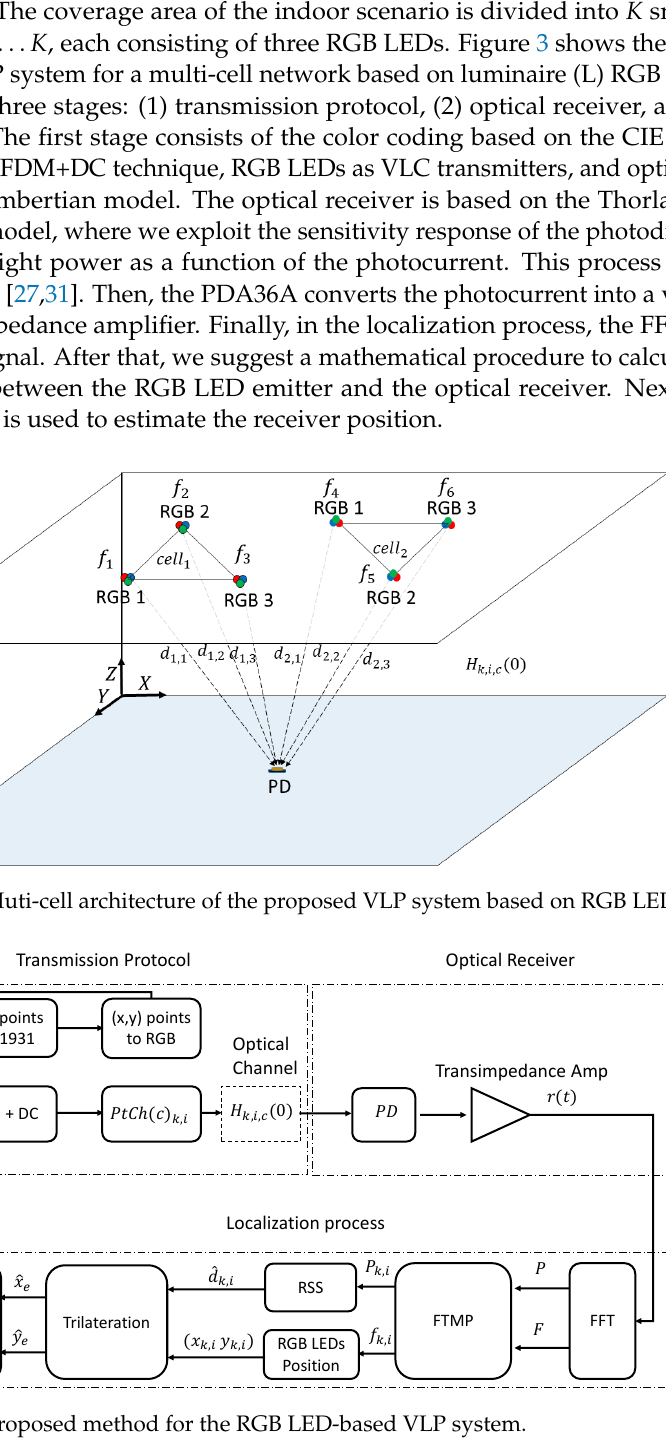
Figure 3. Proposed method for the RGB LED-based VLP